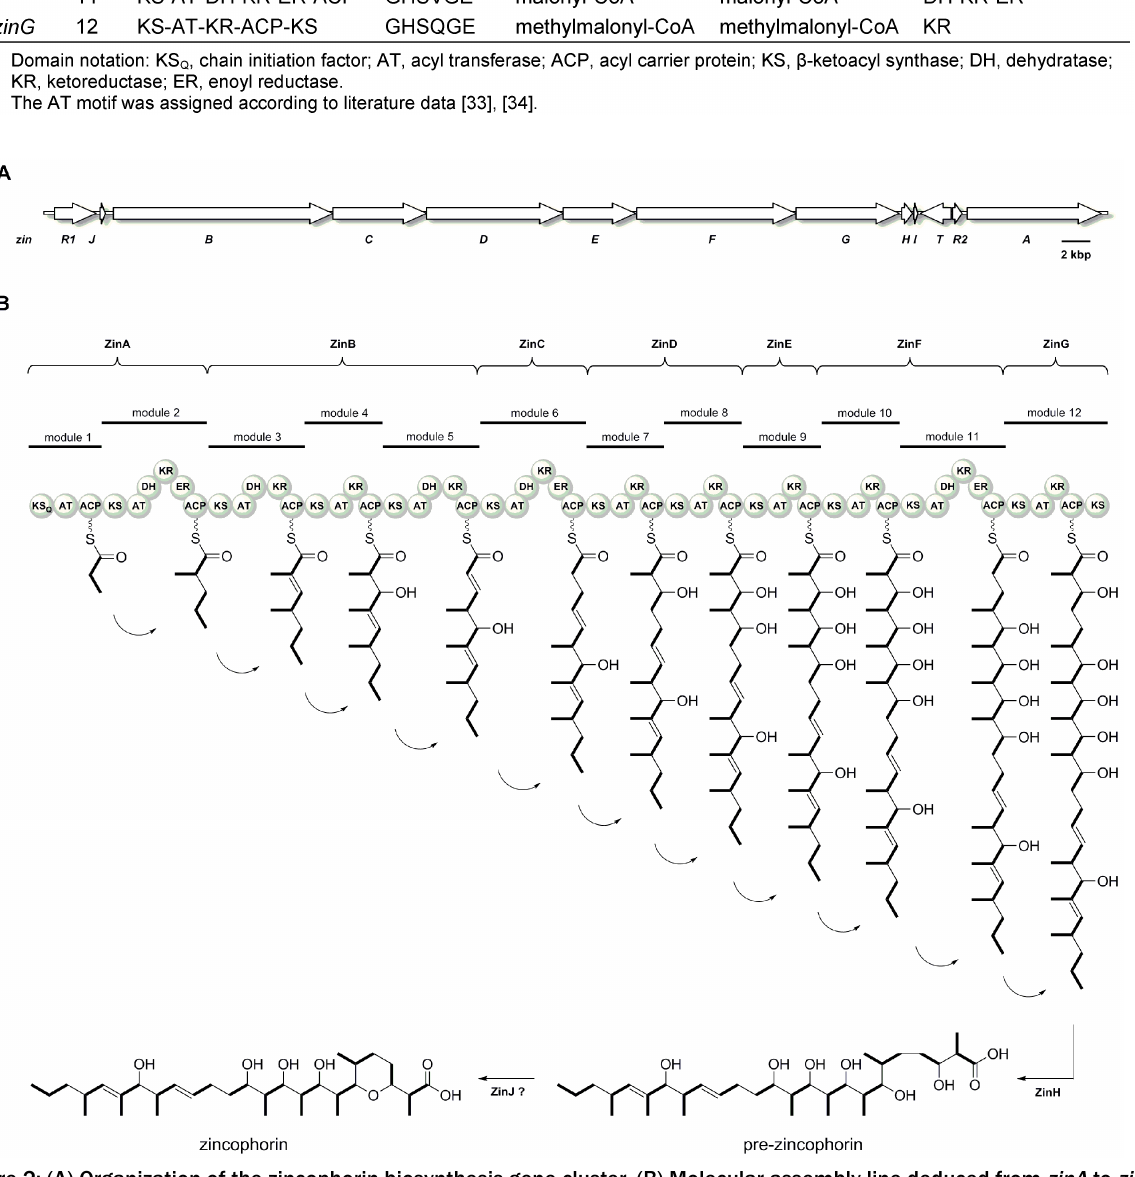
and C building blocks 2 3